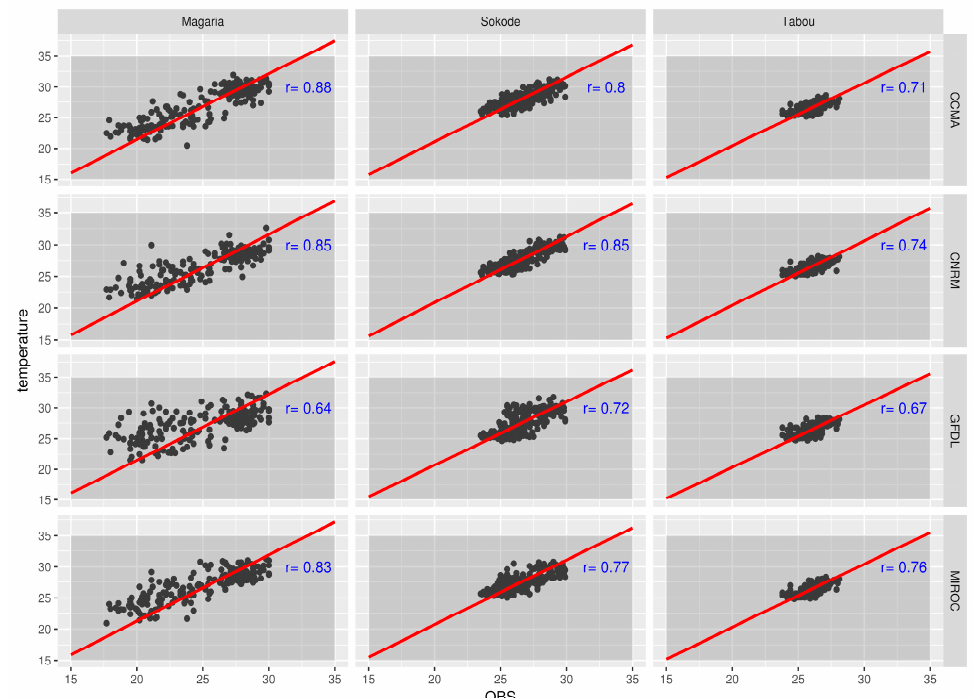
Figure 3. Mean monthly temperature ( ◦ C) as depicted by station observations and statistically downscaled CMIP5 GCMs (CCMA, CNRM5, GFDL, and MIROC) across the three agro ecological zones, Tabou, Sokode, and Magaria, of West Africa for the period 1980–2000. The top right corner r-values in each panel represent the correlations between the simulated and observed mean monthly temperature.